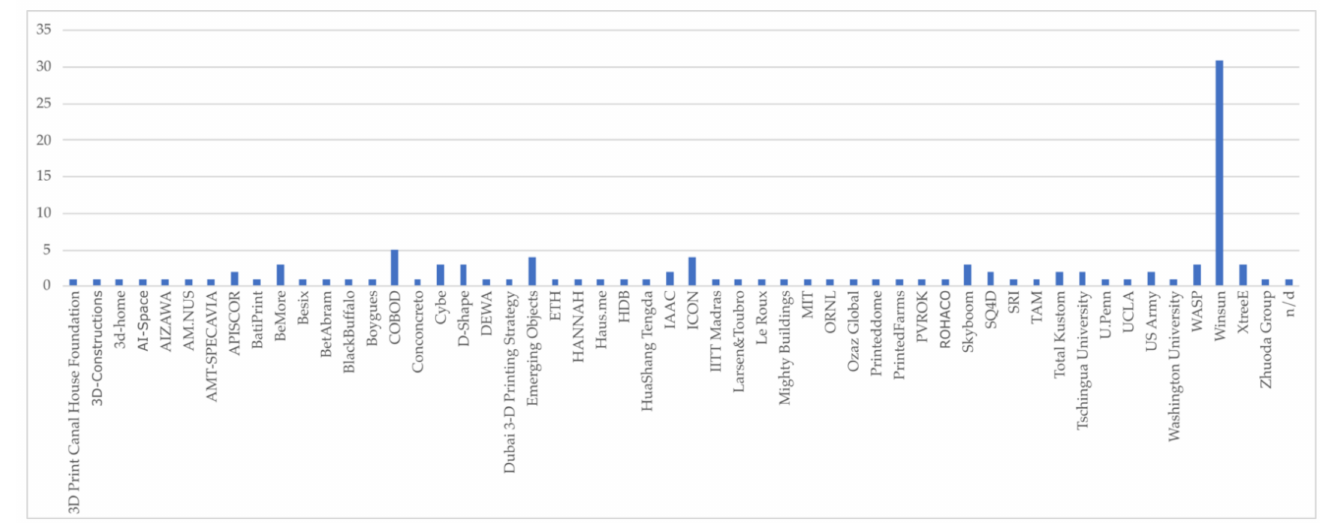
Figure 3. Executors and their respective amount of 3D-printed constructions